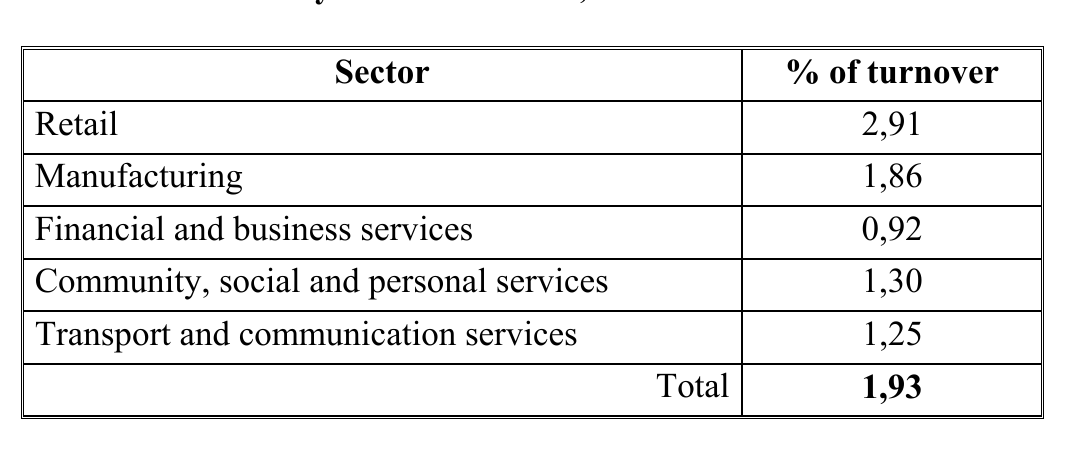
Size of promotional expenditure as percentage of company turnover by economic sector, 2001 Sector % of